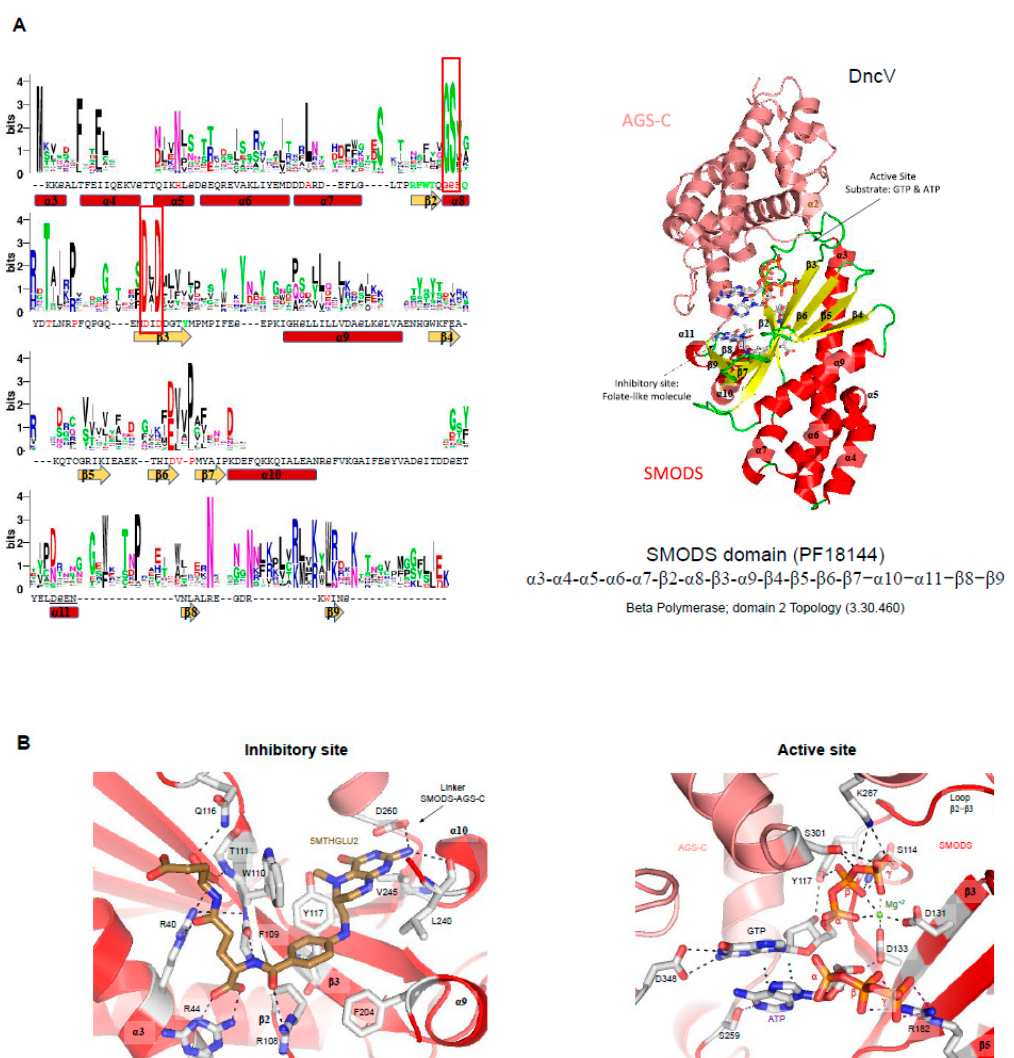
Figure 5. Conserved sequences within SMODS members and their substrate and inhibitor binding pockets. ( A ) residue frequency in SMODS proteins. Forty-five sequences were used from the Pfam database to create a multiple sequence alignment of the SMODS domain of different proteins using ClustalW [116], and the sequence logo was done using the WebLogo server [90]. The sequence shown below the logo and the secondary structure elements belong to the Vibrio cholerae dinucleotide cyclase DncV (PDBID: 4U03). Residues colored in green are involved in the interaction between the DncV SMODS domain with the folate-like inhibitor, 5-methyltetrahydrofolate diglutamate (5MTHFGLU2) molecule (residues Arg36, Arg40, Arg44, and Asp260, be located at the AGS-C domain, are not shown). Residues located at the SMODS domain involved in the catalytic activity are colored in red (residues Ser259, Lys287, Ser301, and Asp348, located at the AGS-C domain, are not shown). The red boxes contain the G(G/S) and Dx(D/E) motifs found in members of NTS. The structure shown in the right belongs to the DncV protein (PDBID: 4U03), in which the AGS-C is colored in salmon and the SMODS domain is colored by secondary structure ( β -strands in yellow and α -helices in red). The SMODS domain topology is shown below the structure, and the CATH topology name and code are also shown [91]; ( B ) interaction network between the DncV binding pocket (active site) and its inhibitory site with substrate and inhibitor molecules, respectively. The substrates GTP and ATP are found bound at the active site, while the folate-like molecule (5MTHGLU2) binds at the allosteric site, inactivating the protein. The residues interacting with substrate and inhibitor molecules are shown as sticks and colored by element: the inhibitor carbons are colored brown, the magnesium ion is shown as a green sphere, and gray dotted lines represent hydrogen